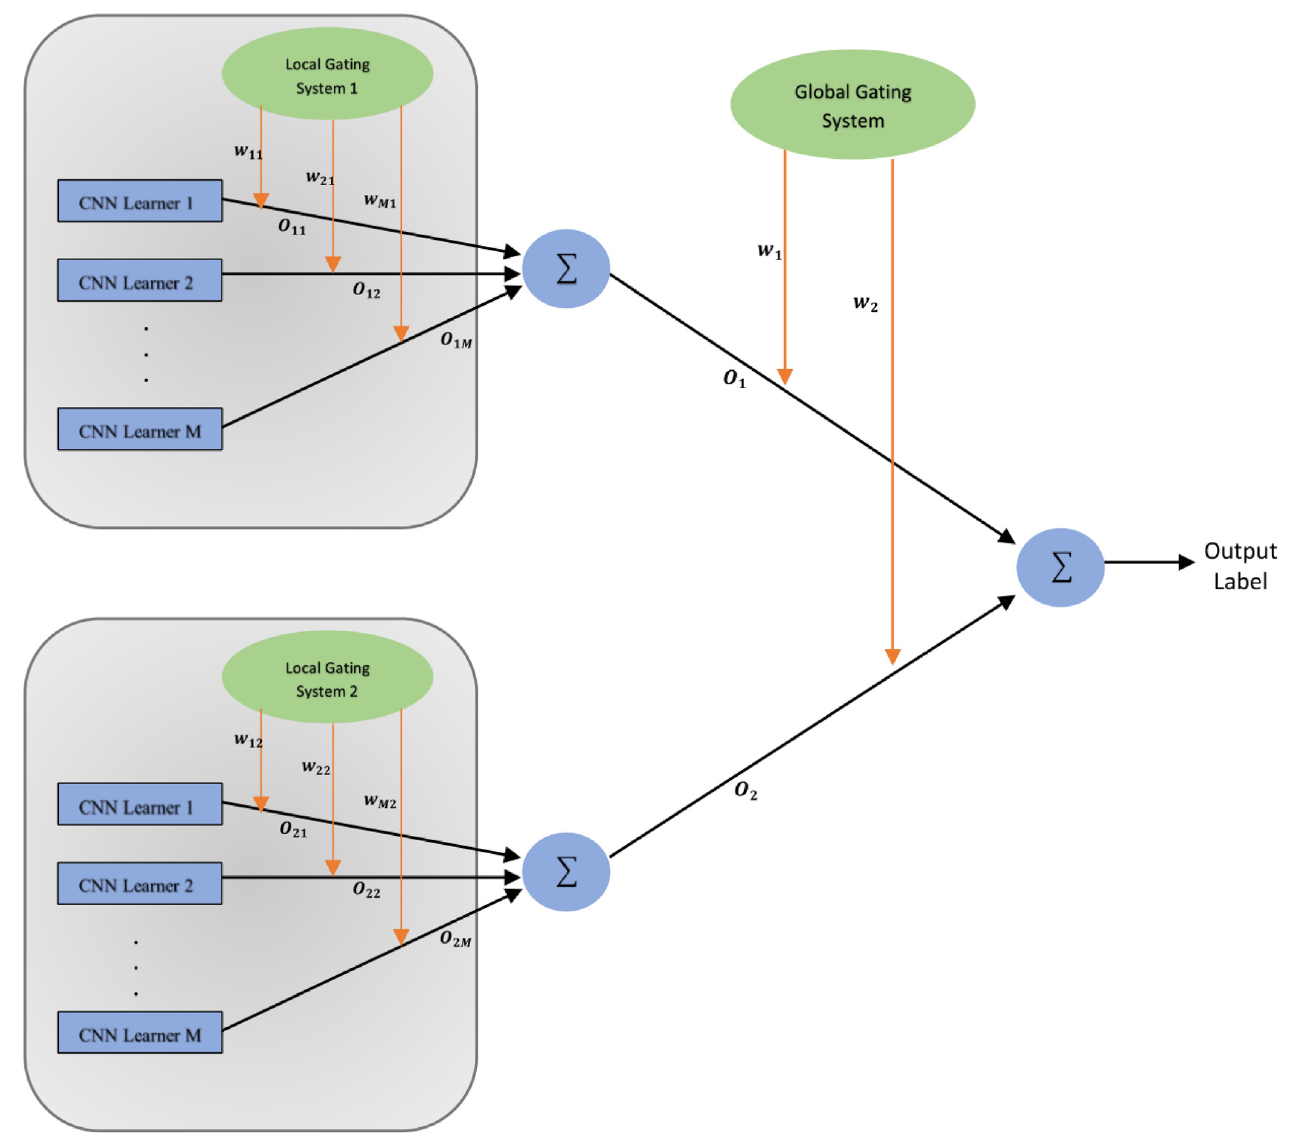
Fig 5. Illustration of the proposed HE-CNN model (Two-level